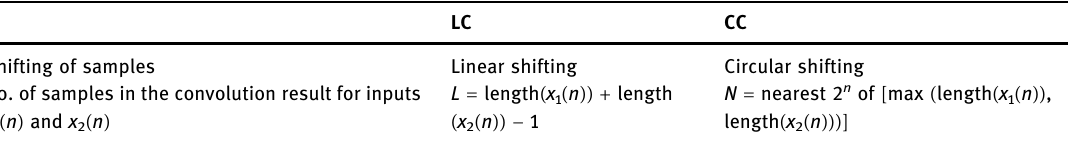
Table 1: Comparison between LC and CC LC CC Shifting of samples Linear shifting Circular